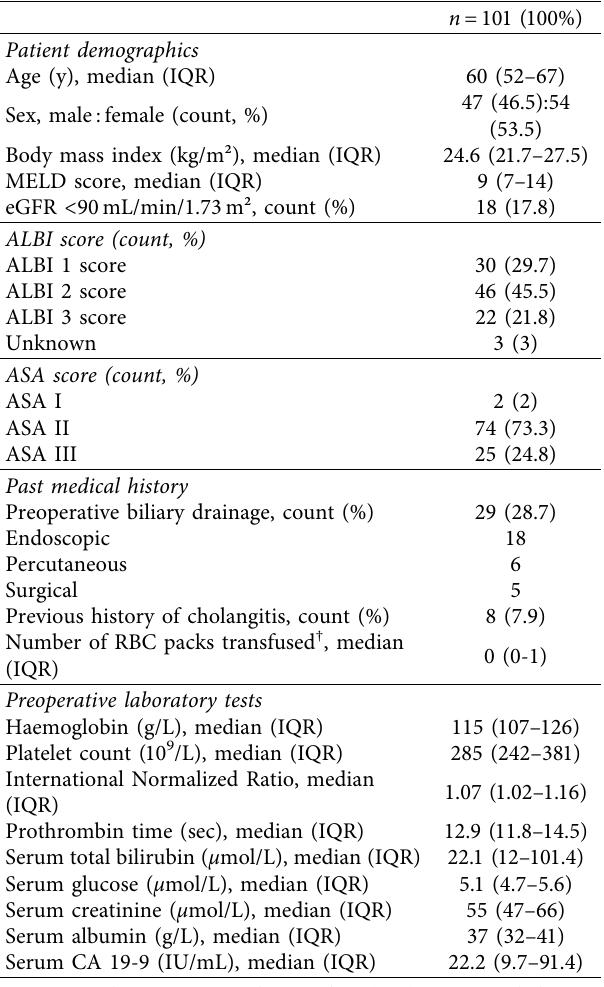
Table 1: Clinical, laboratory, and operative patient